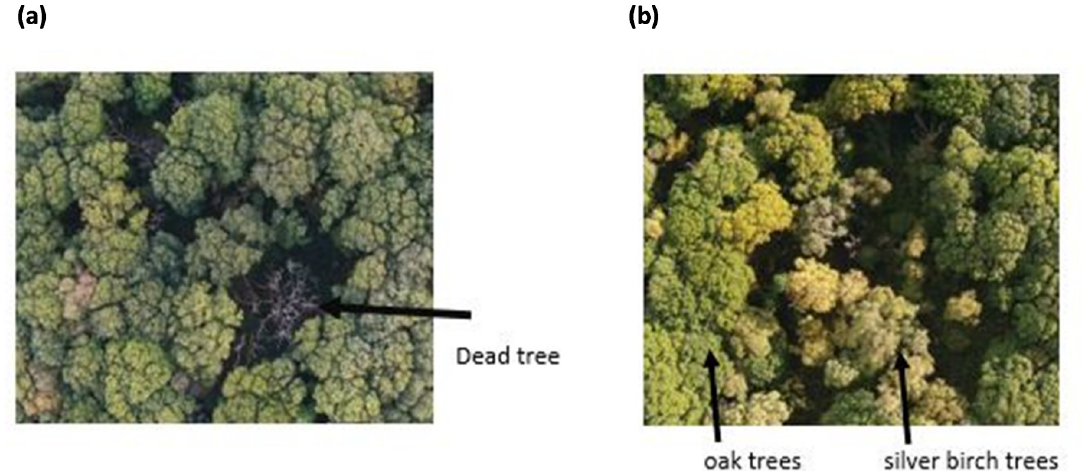
Fig 5. RGB (visible) images from the data set of the central area of Priestclose Wood (a) Dead trees with a canopy coverage of oak trees (b) Oak and silver birch